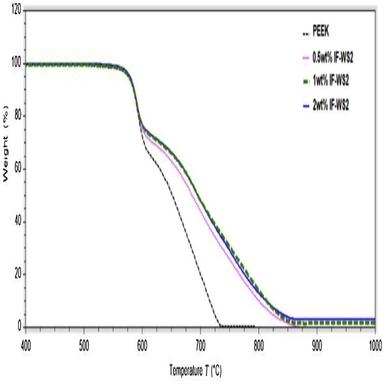
Variation of sample weight with temperature for PEEK samples with 0, 0.5, 1 and 2 wt% IF-WS2.